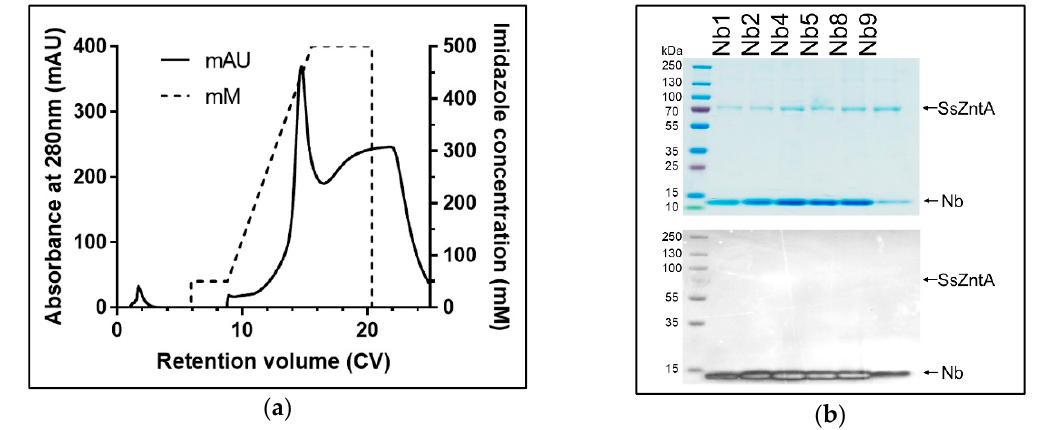
Figure 9. SsZntA-Nb complex analysis using affinity chromatography: SsZntA + Nb. ( a ) Chromatogram of HisTag-free SsZntA incubated with HisTagged Nb1. The complex elutes at 400 mM imidazole and is here reported as representative of the other Nbs. ( b ) Coomassie (top) and InVision ® (bottom) stained SDS-PAGE of the eluted fractions at 400 mM imidazole of HisTag-free SsZntA in complex with, respectively, Nb1-2-4-5-8-9.